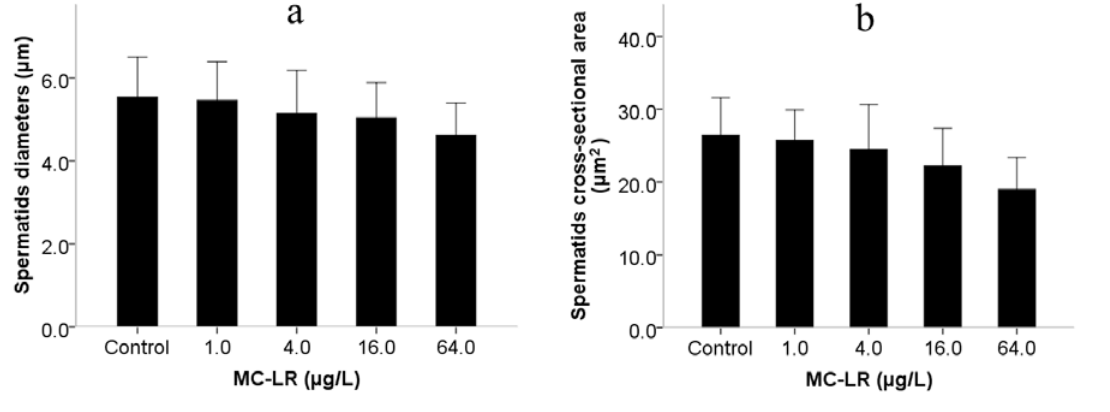
Figure 3. Effects of MC-LR exposure on spermatids size. ( a ) Spermatids diameters; and ( b ) Spermatids cross-sectional area. One male was dissected and 200 spermatids were analyzed. Bars represent means ±